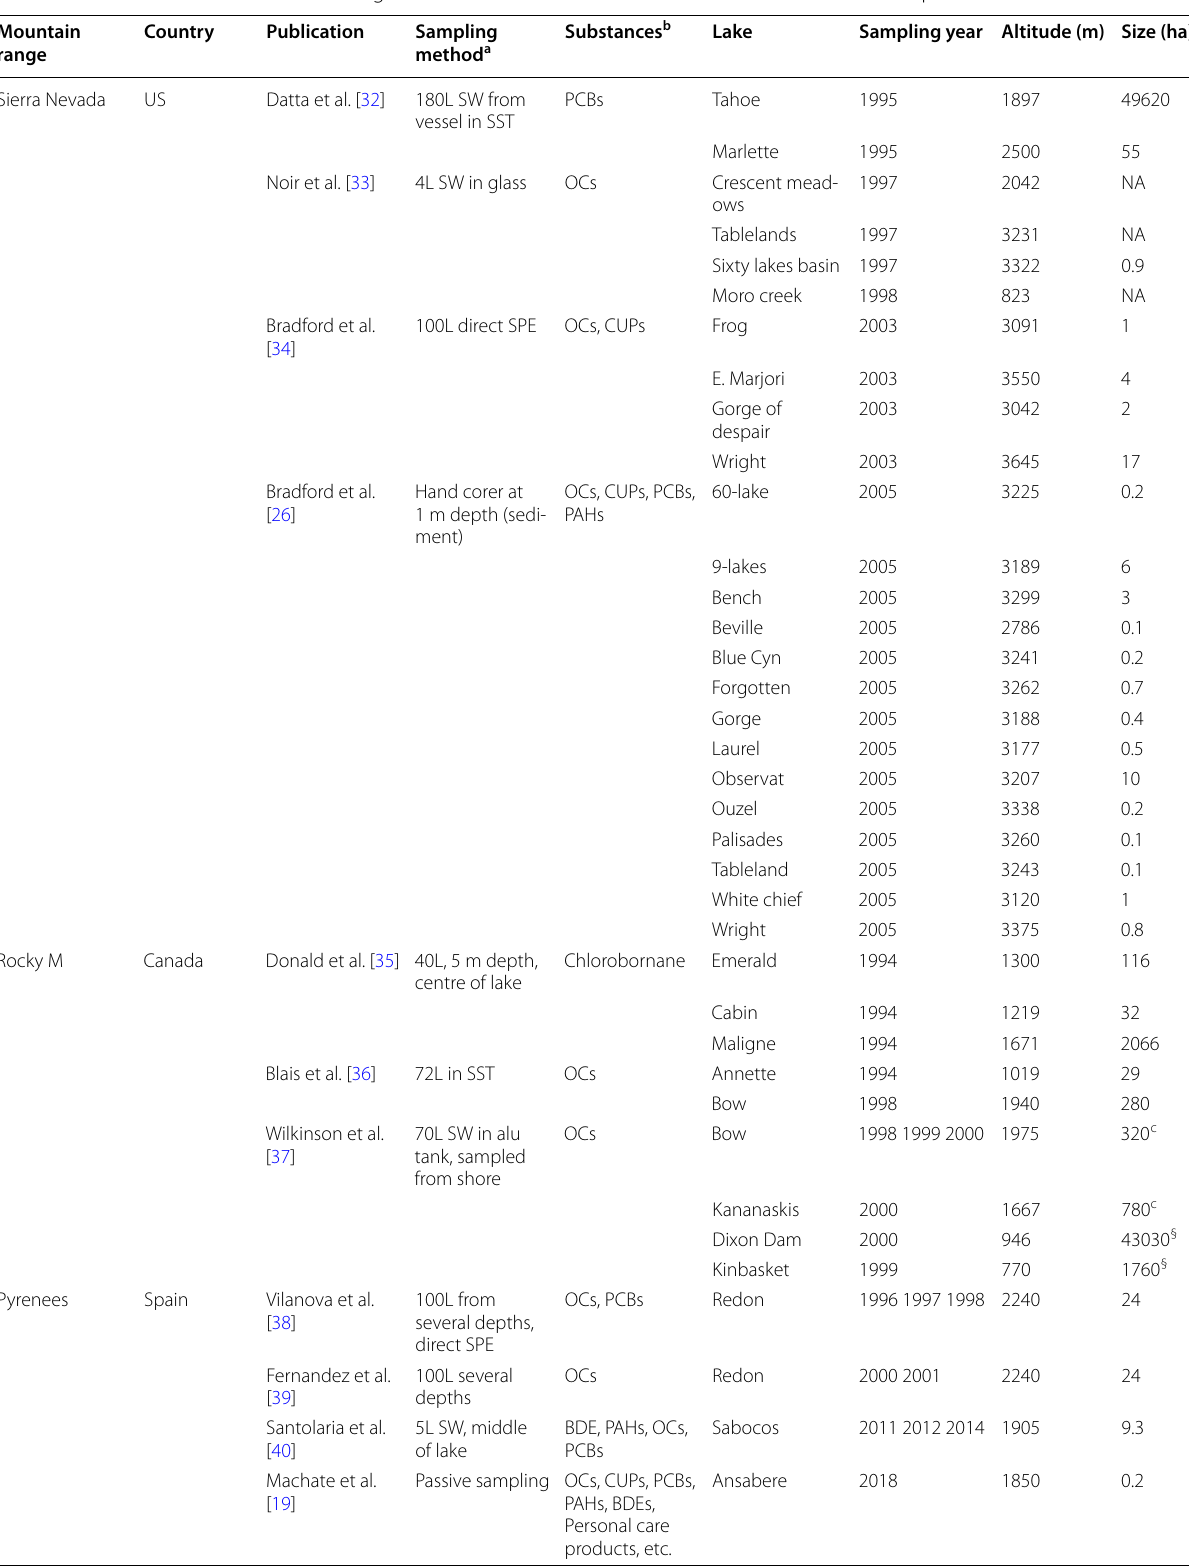
Table 1 Overview of studies documenting water concentration data for mountain lakes from different parts of the world Mountain